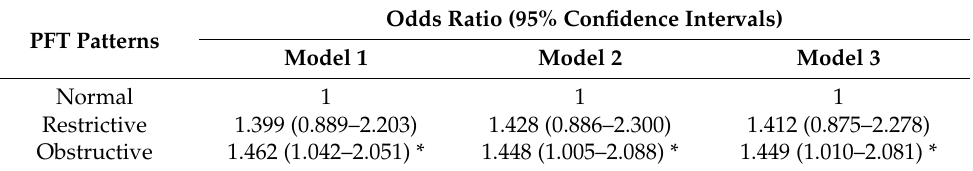
Table 3. Adjusted odds ratios of olfactory dysfunction according to pulmonary